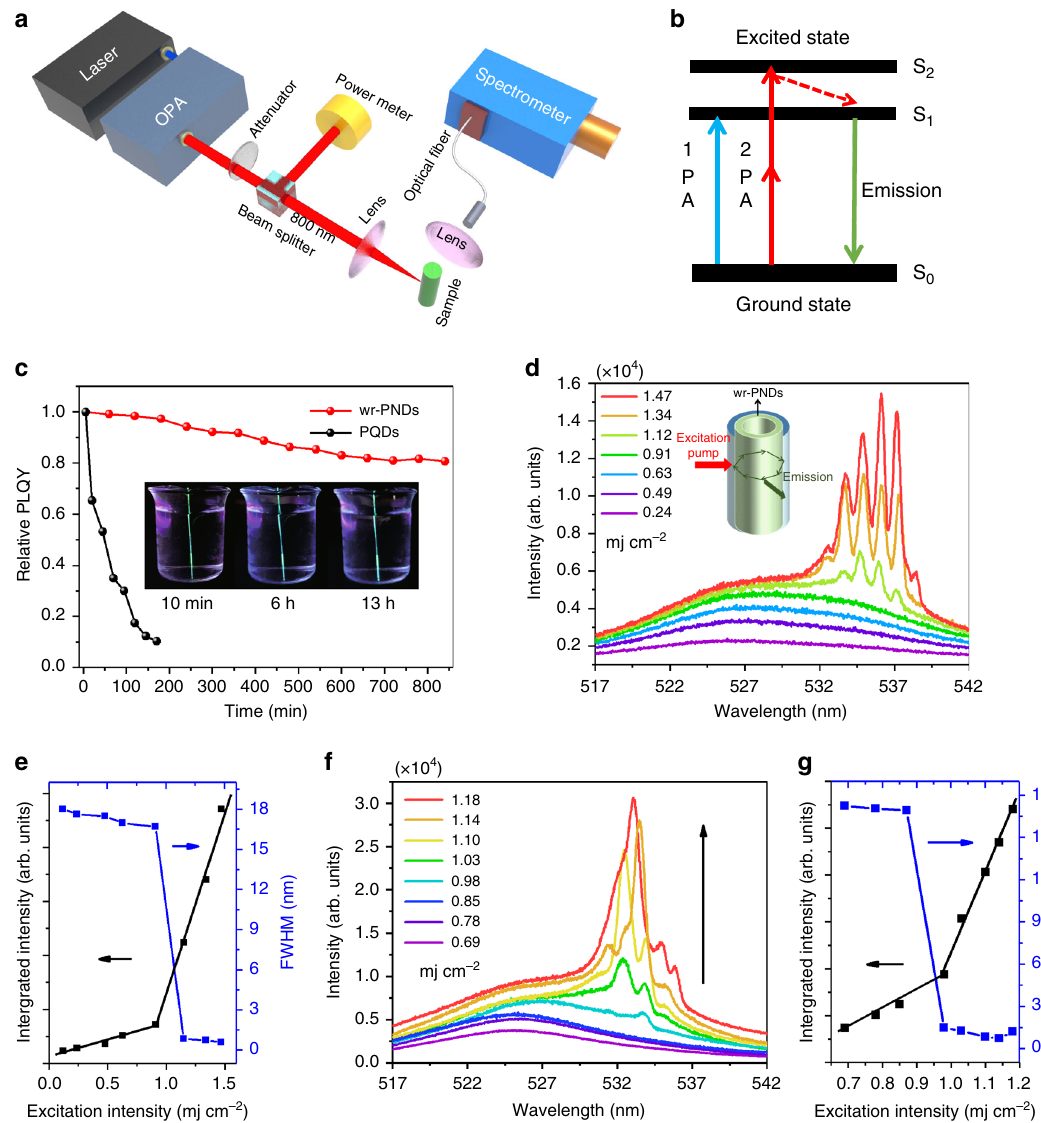
Fig. 4 wr-PNDs based water-proof two-photon pumped lasers. a Pumping con fi guration used in two-photon lasing measurements. b Jablonski diagram of the two-photon absorption and emission in wr-PNDs and PQDs. c Relative PLQYs of the laser devices (measured in an integrating sphere under 375 nm laser excitation) based on wr-PNDs (red dots) and pristine PQDs (black dots), which were immersed in water for different periods of time. The insets are the photographs of the wr-PNDs-based laser in water taken at different time under UV light illumination. d Emission spectra and e integrated intensity and emission FWHM for the wr-PNDs-based laser immersed in water for 13 h, as a function of pumping intensity under 800 nm fs laser excitation. The insert in d sketches the capillary-like microcavity laser device. f Emission spectra and g integrated intensity of the wr-PNDs-based random laser device stored in water for 15 days. Source data are provided as a Source Data fi